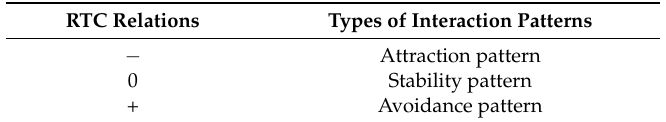
Figure 2. Illustration of the TM.